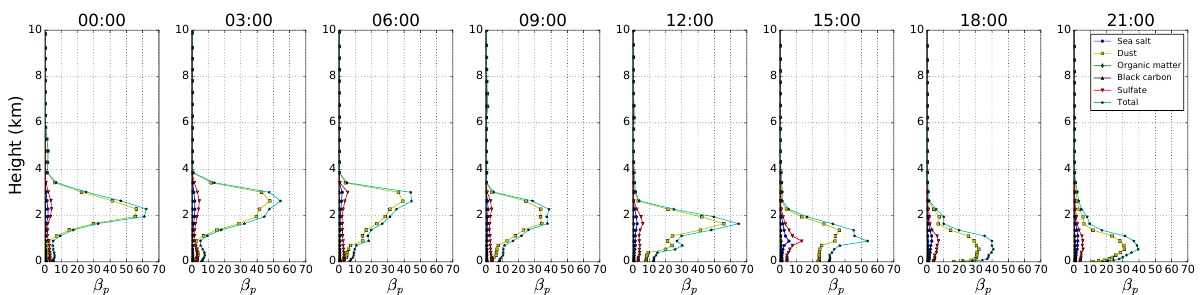
Figure 11. Same as Fig. 10 but for 3 April 2016.